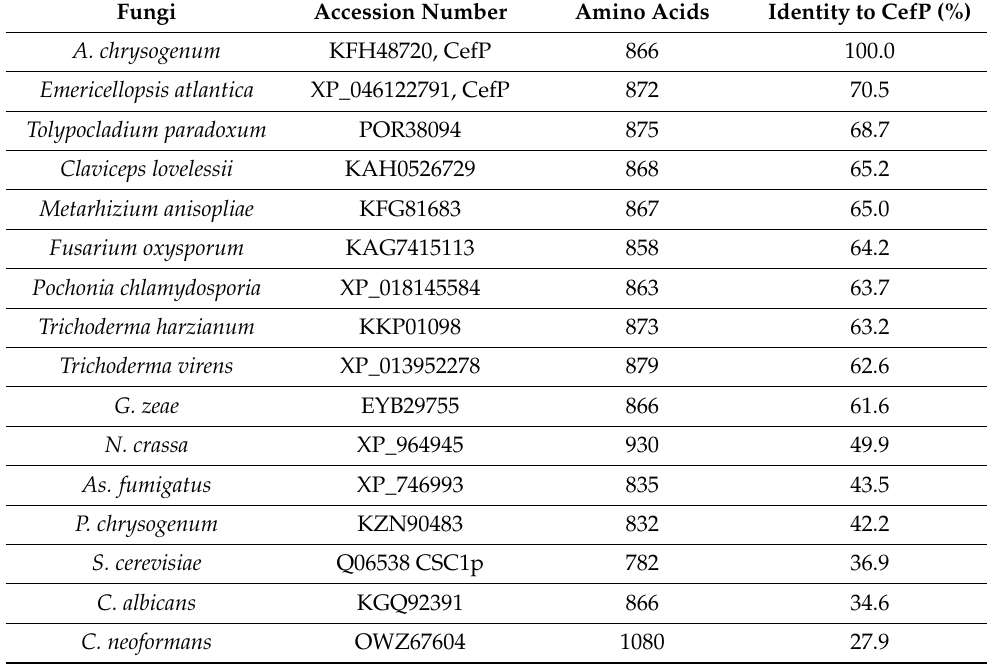
Table 2. CepP-like proteins in different filamentous